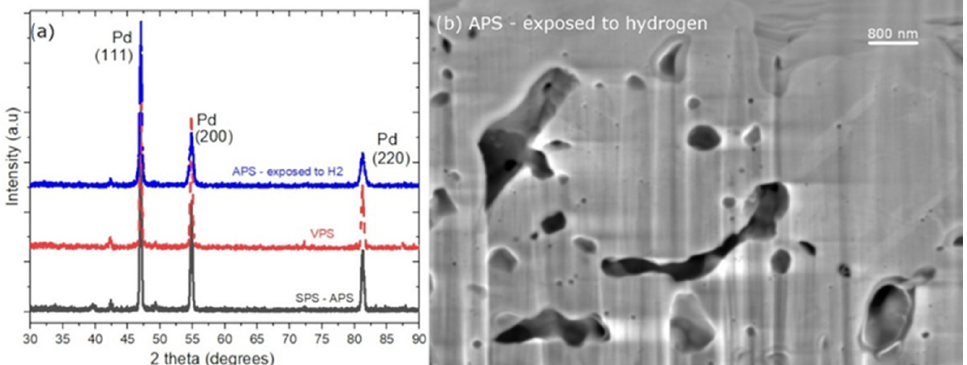
Figure 5. XRD patterns of the coated samples using a Co-source ( a ); samples of SPS-APS (black straight line), VPS (red dotted line), and APS exposed to H 2 at 300 °C, 20 bars, for 75 h (blue dotted line). ( b ) SEM image of the APS sample showing remaining pores after treatment with H 2 at 300 °C, 20 bars, for 75 h.